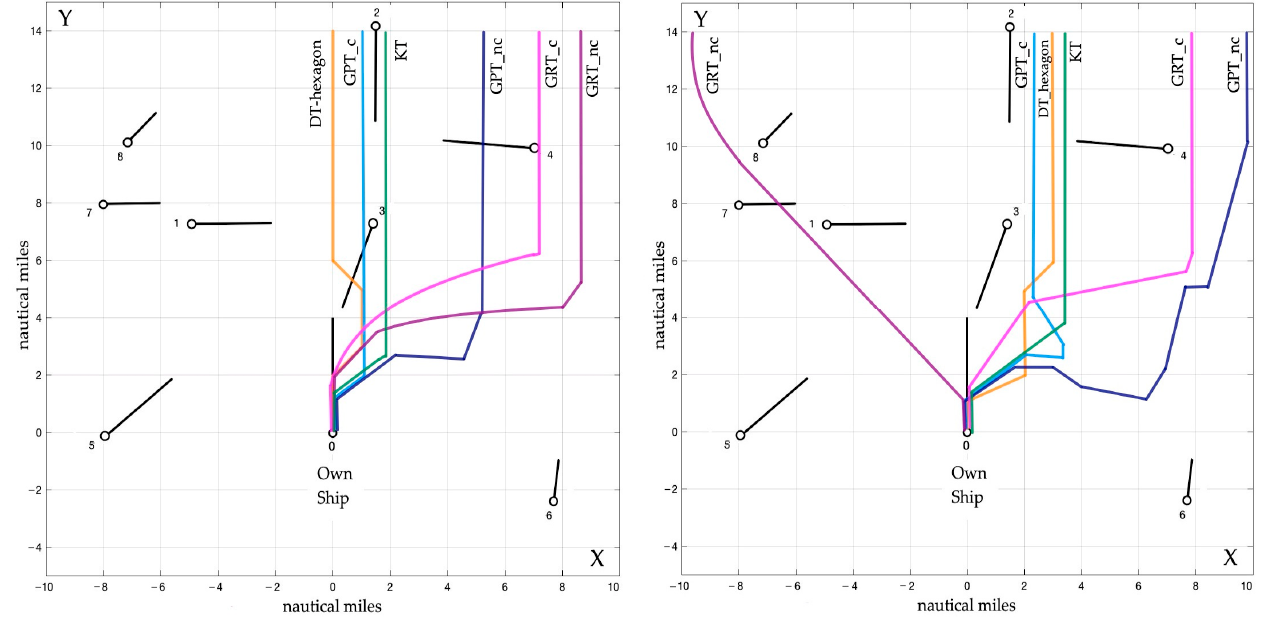
Figure 17. Safe ship trajectories determined according to DT, GPT, GRT, and KT algorithms for good visibility at sea ( left ) and restricted visibility at sea ( right ) conditions.